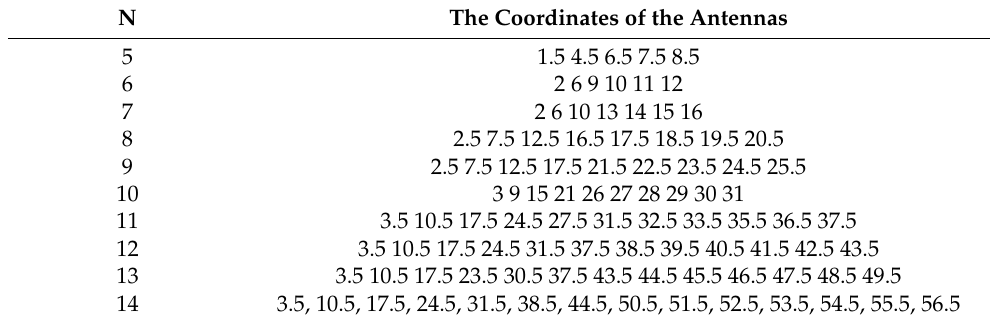
Table 1. Optimal array configurations for 1-D MAS. N The Coordinates of the